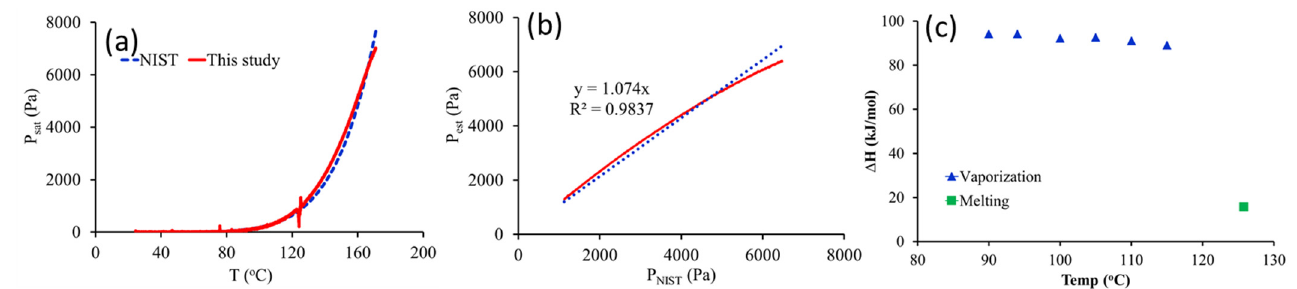
Figure 2. For benzoic acid ( a ) Saturation vapor pressure as a function of temperature, ( b ) correlation of saturation vapor pressure estimated in this study and that reported by NIST, and ( c ) estimated enthalpies of sublimation, melting, and vaporization as a function of temperature.